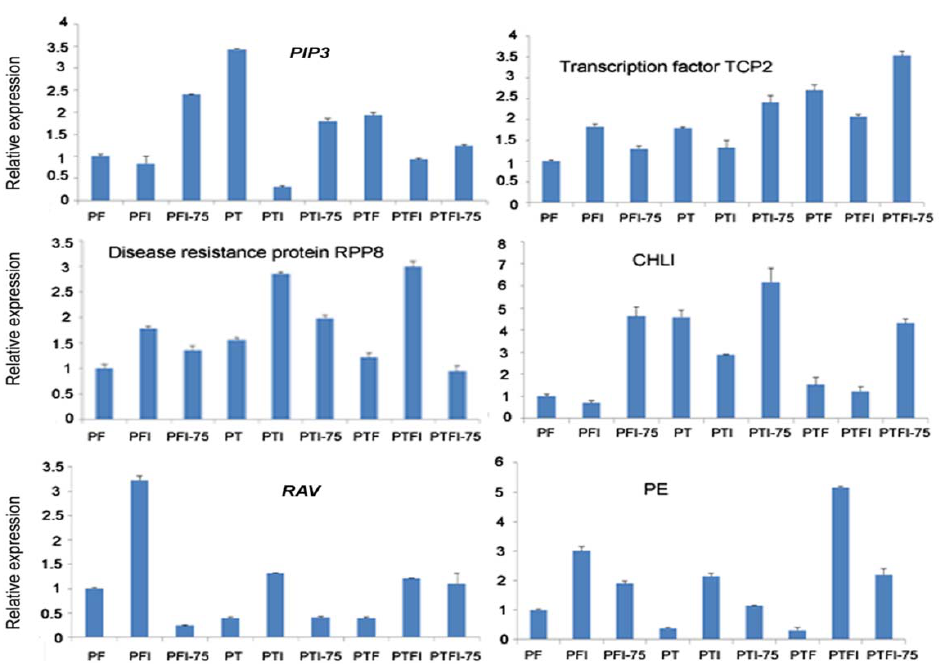
Figure 5. qPCR analysis of the expression level of the target genes of the selected miRNAs.